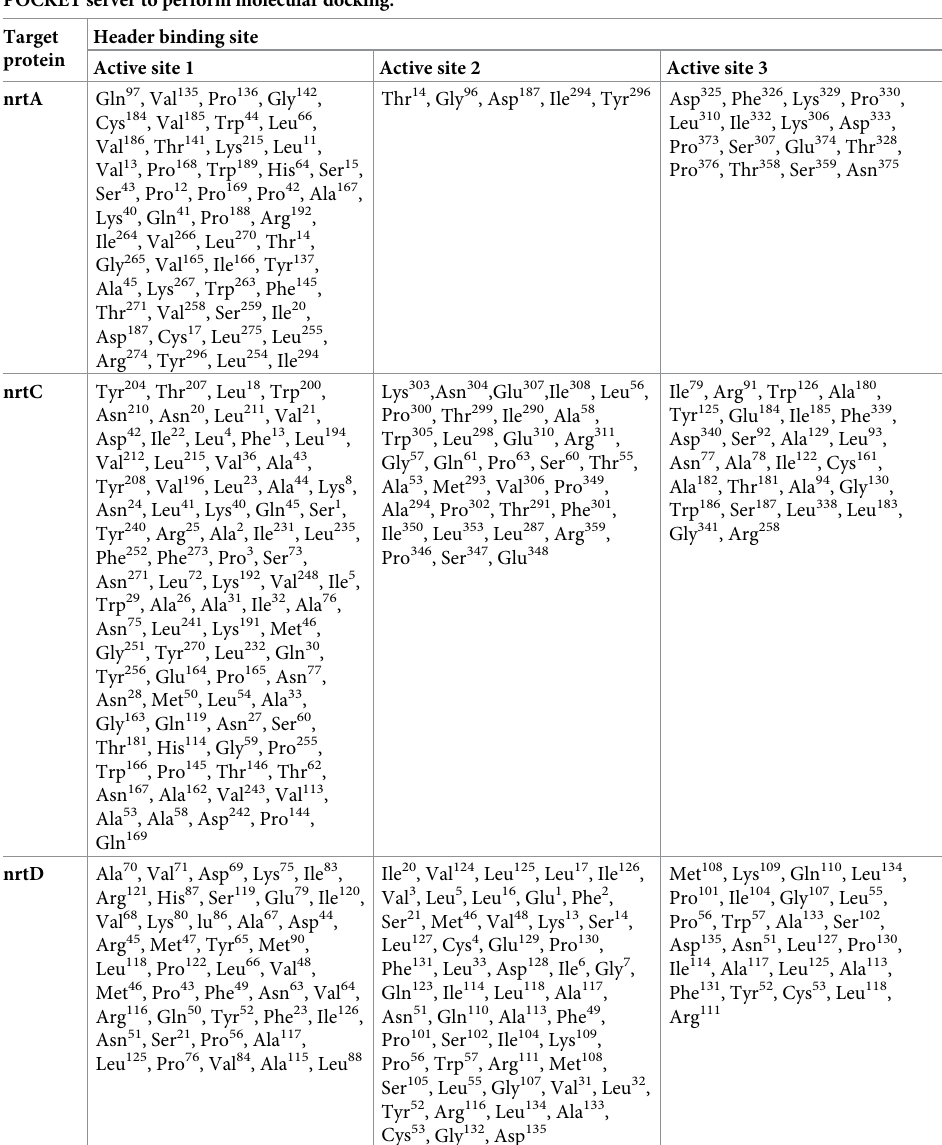
Green color amino acid residues are located on the prominent active